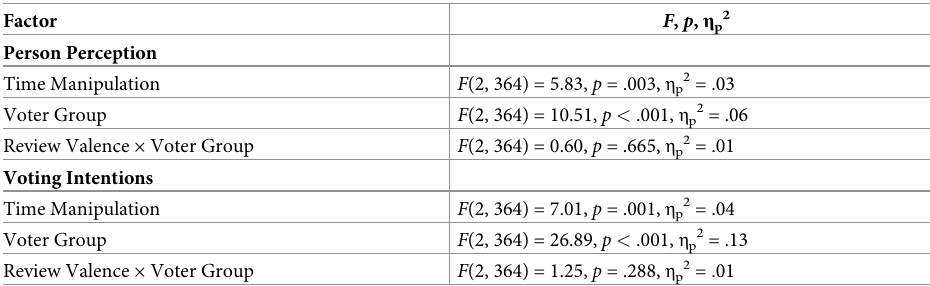
Table 6. Main effects and interactions for additional outcome